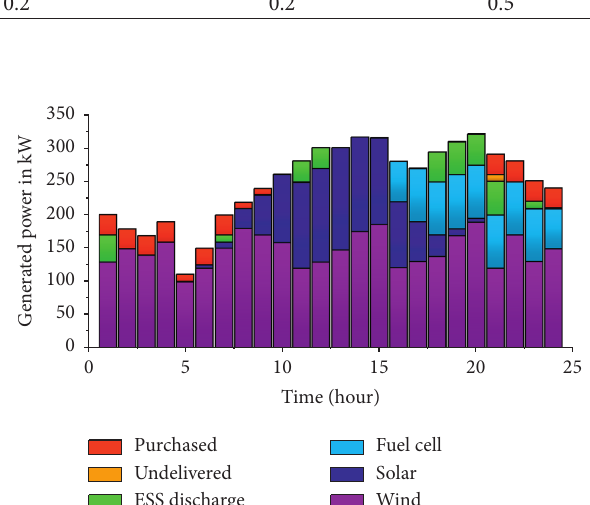
Figure 6: The optimum scheduling for the produced power of various power sources and purchased power from the power market (the basic scenario).